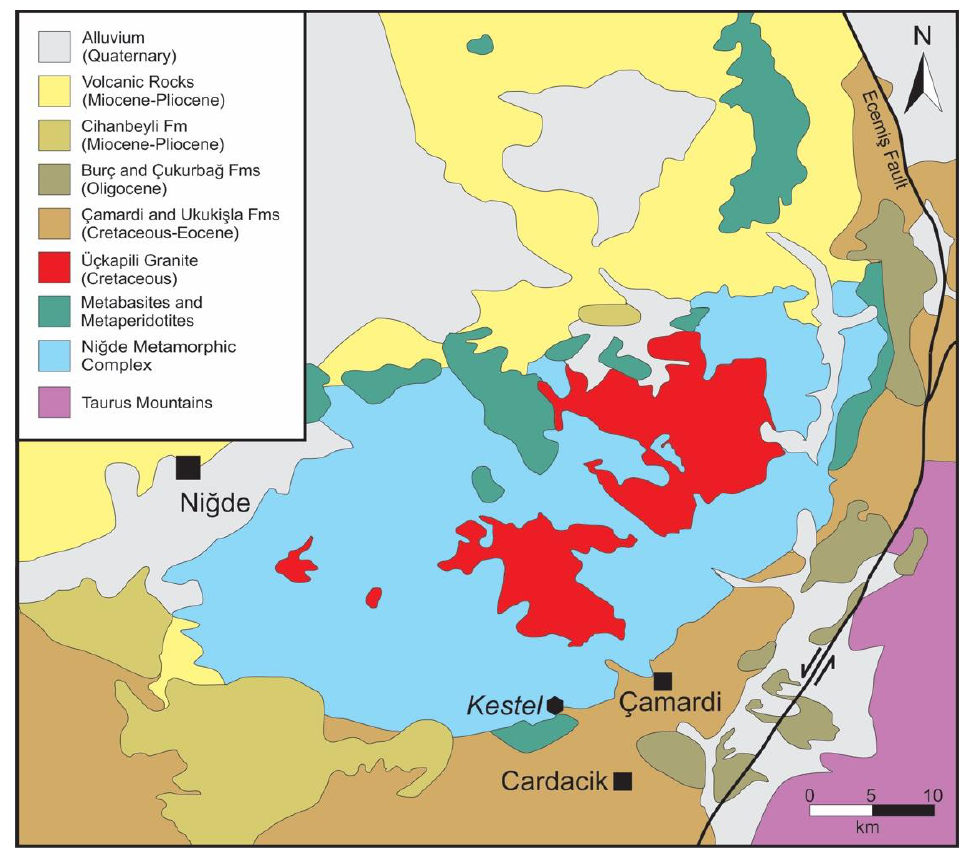
Figure 2. Geology of the Niğde Massif and surrounding area [14].